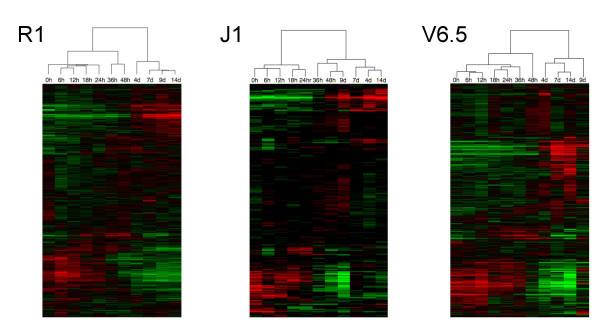
Clustered heat maps for differentiation time-course experiments in three mouse ES cell lines: R1, J1, and V6.5. Expression values for 1,605 probe sets, corresponding to 1,327 transcription factor genes (according to protein domain analysis), were extracted from data from the MOE430A microarray for 11 time points from 0 hours to 14 days. The data for each cell line were mean-centered by probe set and by array, and clustered using Cluster 3.0 (University of Tokyo). Clusters were visualized using Java TreeView [72].